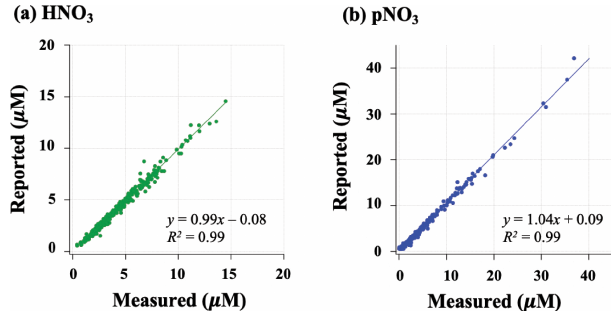
Figure 2. Relationship of HNO 3 (a) and pNO 3 (b) filter extract concentrations reported by CASTNET and re-measured at Brown